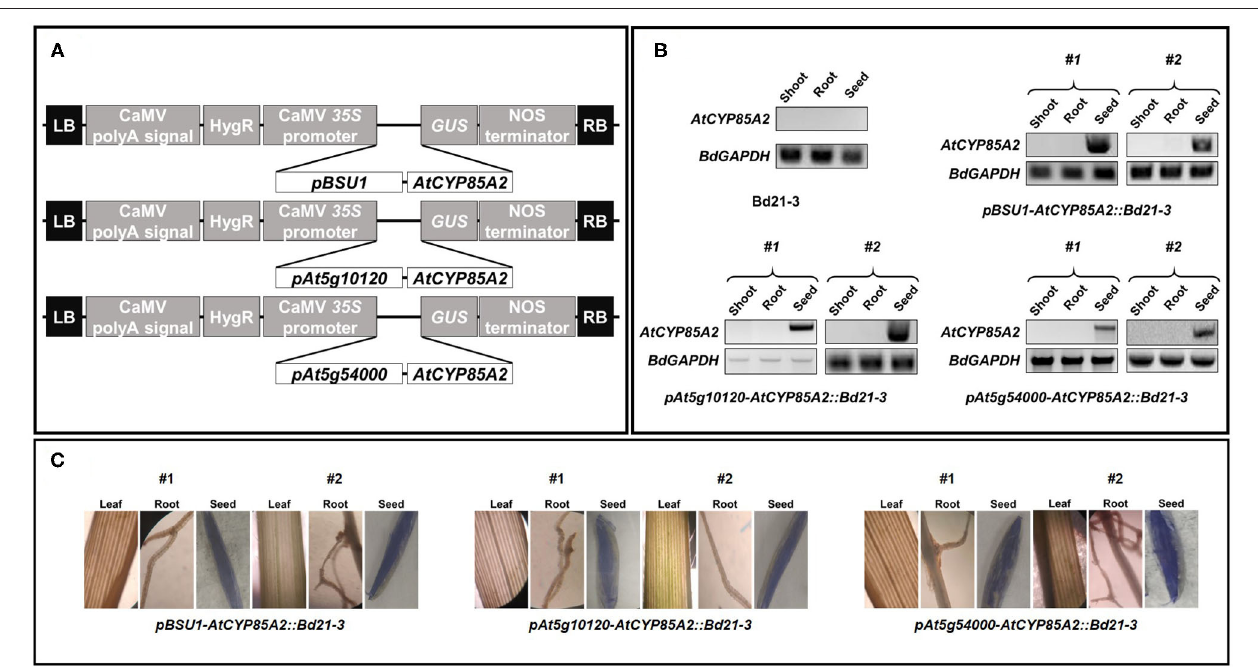
FIGURE 3 | Genetic map of seed-specific AtCYP85A2- expressing constructs and expression level of AtCYP85A2 in transgenic Brachypodium mutants. (A) Genetic map of AtCYP85A2 expressing constructs driven by seed specific promoters, pBSU1, pAt5g10120 , and pAt5g54000 . CaMV polyA signal, the cauliflower mosaic virus polyadenylation signal; HygR, hygromycin resistance gene; CaMV 35S promoter, the cauliflower mosaic virus 35S promoter; GUS , β -glucuronidase gene; NOS terminator, nopaline synthase terminator; LB, left border; RB, right border. (B) Semi-quantitative RT-PCR analysis for expression of AtCYP85A2 in shoot, root, and seed of wild type and transgenic plants. #1 and #2 represent two different lines for three transgenic plants. AtCYP85A2 was only detected in seed of transgenic plants. BdGAPDH is a reference gene. (C) GUS-staining in leaf, root and seed of transgenic Brachypodium mutants. GUS activity was concentrated in seed of transgenic